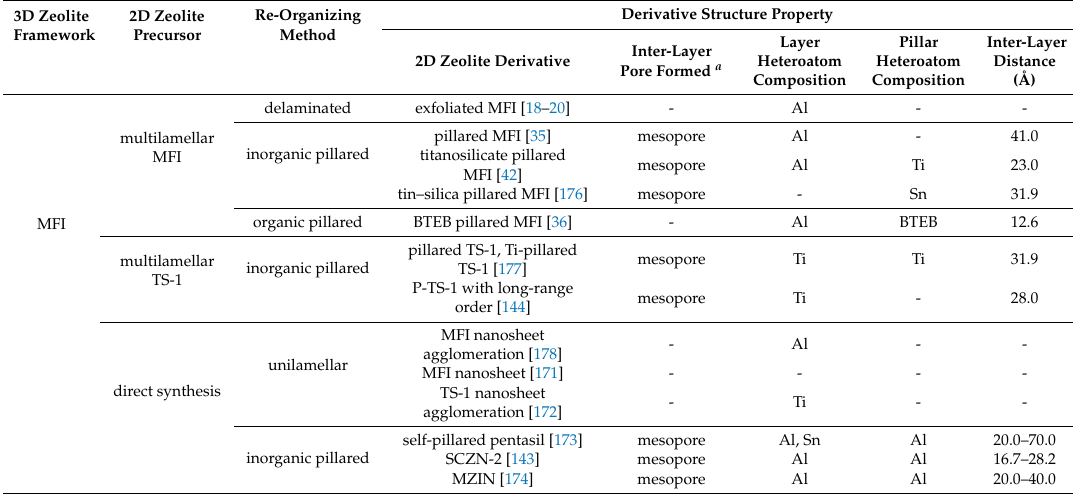
Figure 9. Schematic illustration of structures of 2D MWW (MCM-22 (twenty-two)) and MFI (ZSM (Zeolite Socony Mobil)-5 (five)) layered structures, and the corresponding 3D zeolites. Table 6. Structural and compositional properties of derivatives of 2D MFI